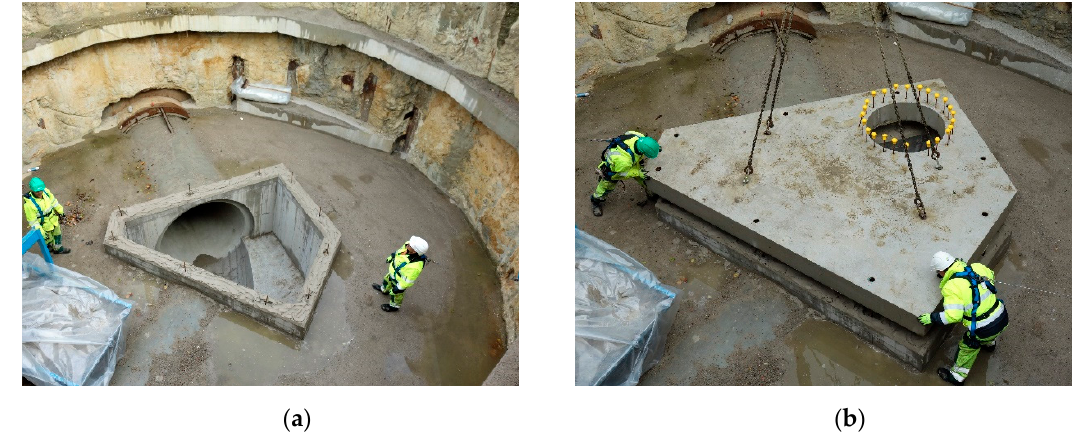
Figure 17. ( a ) Building pit prior to installation of the roof slab. ( b ) Installation of the roof slab on the inspection chamber inside the construction pit.